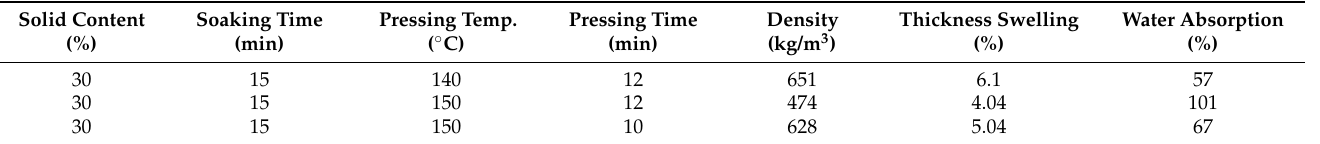
Table 2. Density, water absorption (WA), and thickness swelling (TS) of MGE plywood produced using different solid content, soaking time, pressing temperature, and time.